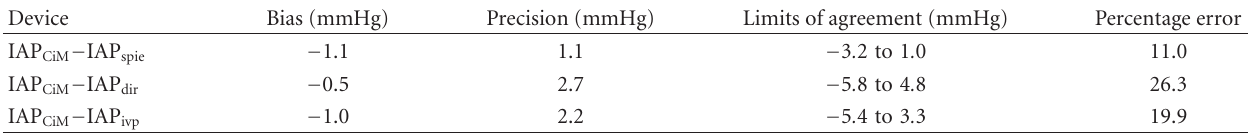
Table 2: Statistics of comparison between di ff erent device readings in the 25 ◦ head-up elevation